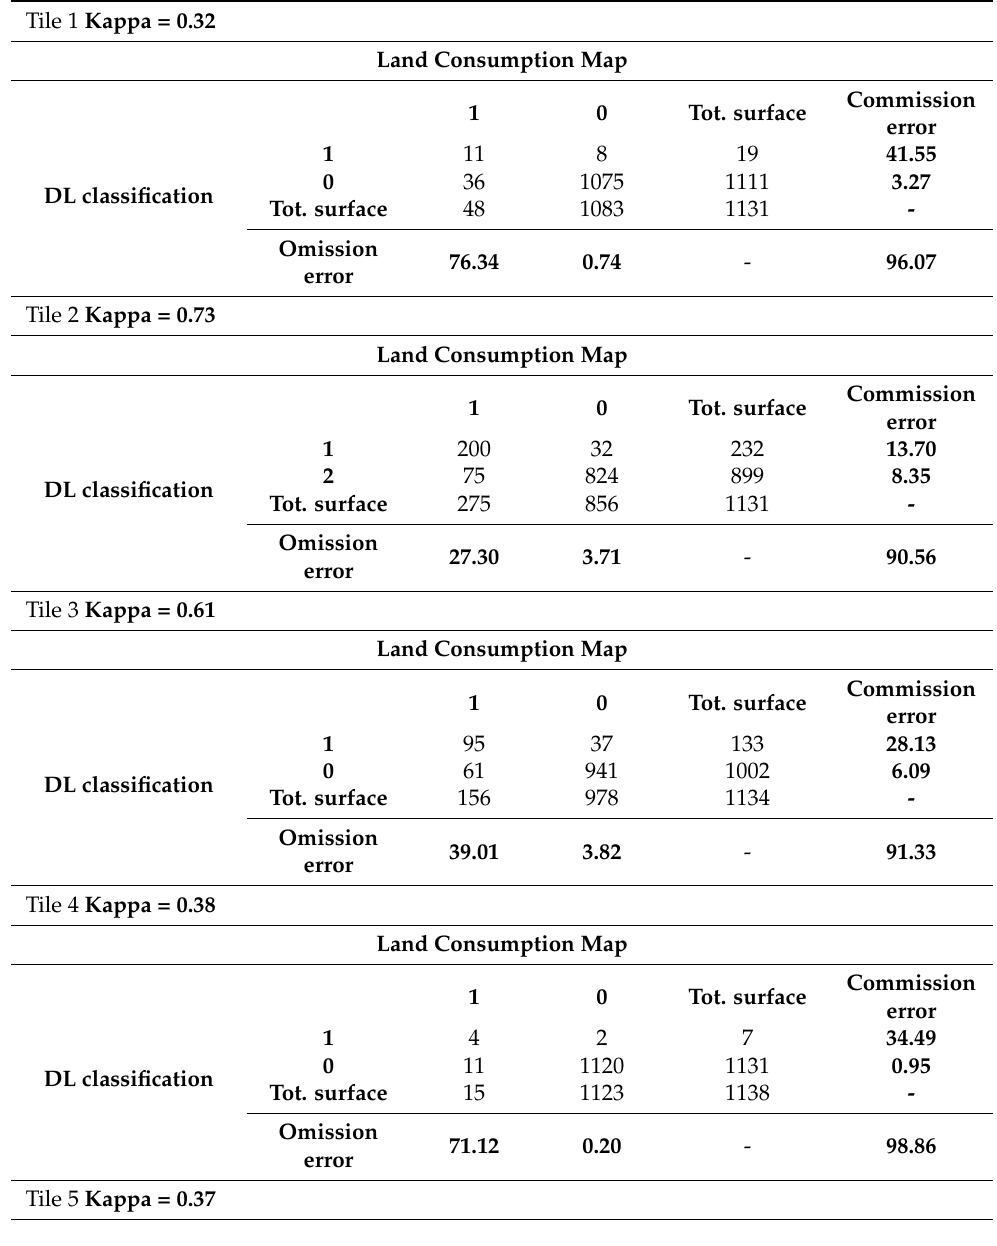
Table 3. Accuracy assessment by comparison with the LCM; 1 = consumed land, 0 = non-consumed